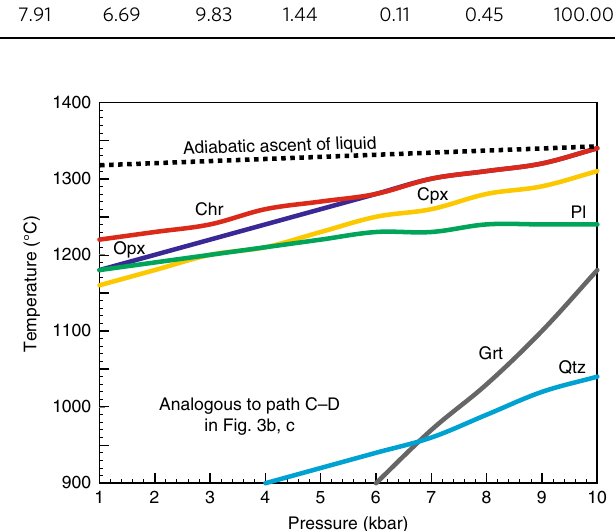
Fig. 4 Thermodynamic modelling indicating the mechanism via which basaltic melts become saturated in chromite alone by pressure